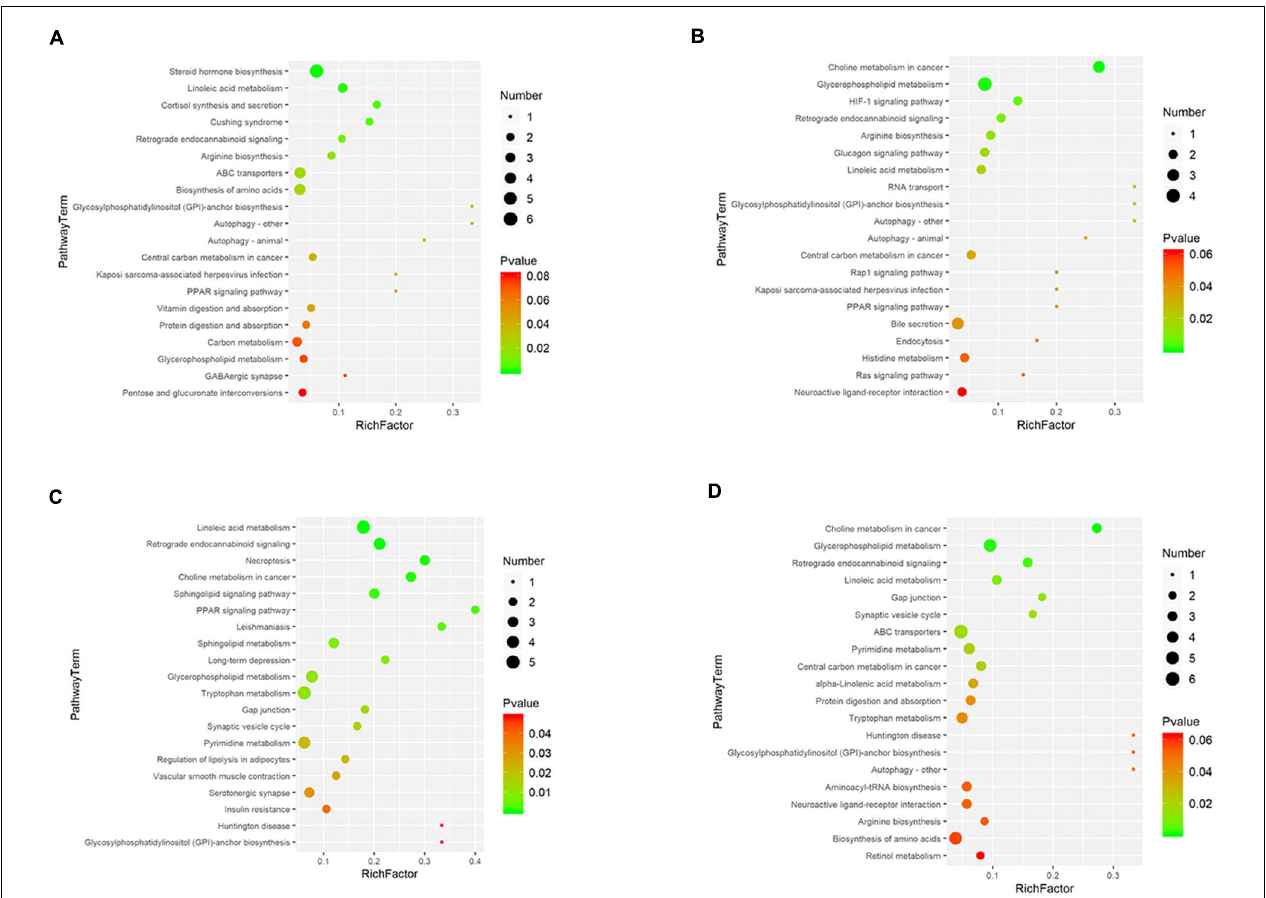
FIGURE 4 | Disturbed metabolic pathways. Bubble charts show the top 20 metabolic pathways that the differentially expressed metabolites enriched in between the pretreatment and the postoperation groups ( A: con vs. 1 h, B: con vs. 1 day, C: con vs. 3 days, D: con vs. 7